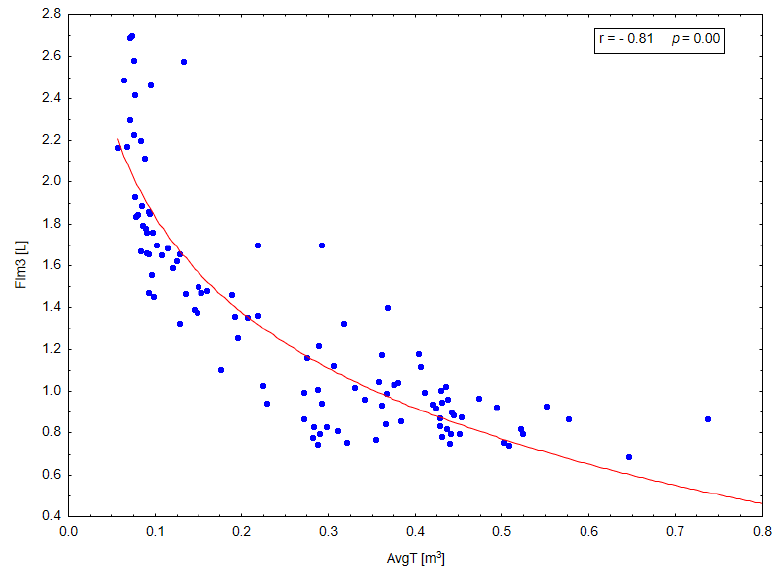
Figure 1. Relationship between mean tree size (AvgT) and relative fuel consumption (Flm3) per cubic meter; each point represents a working day.